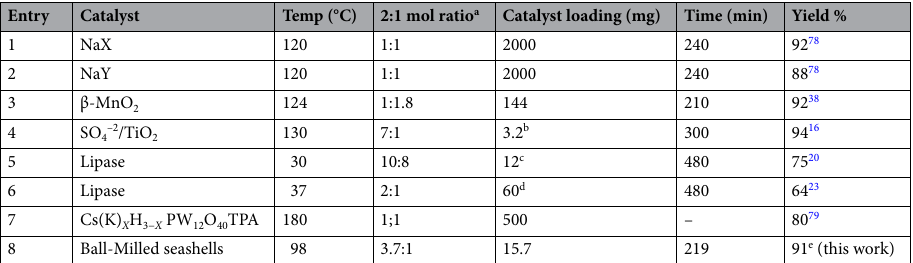
Table 3. Comparison of the performance of various catalysts versus ball-milled seashells ( 3 ) in the esterification of isoamyl alcohol ( 1 ) with acetic acid ( 2 ). a Molar ratio of acid:alcohol. b 3.2 wt % with respect